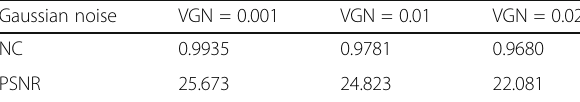
Table 1 Adding the Gaussian noise attack with Example 1